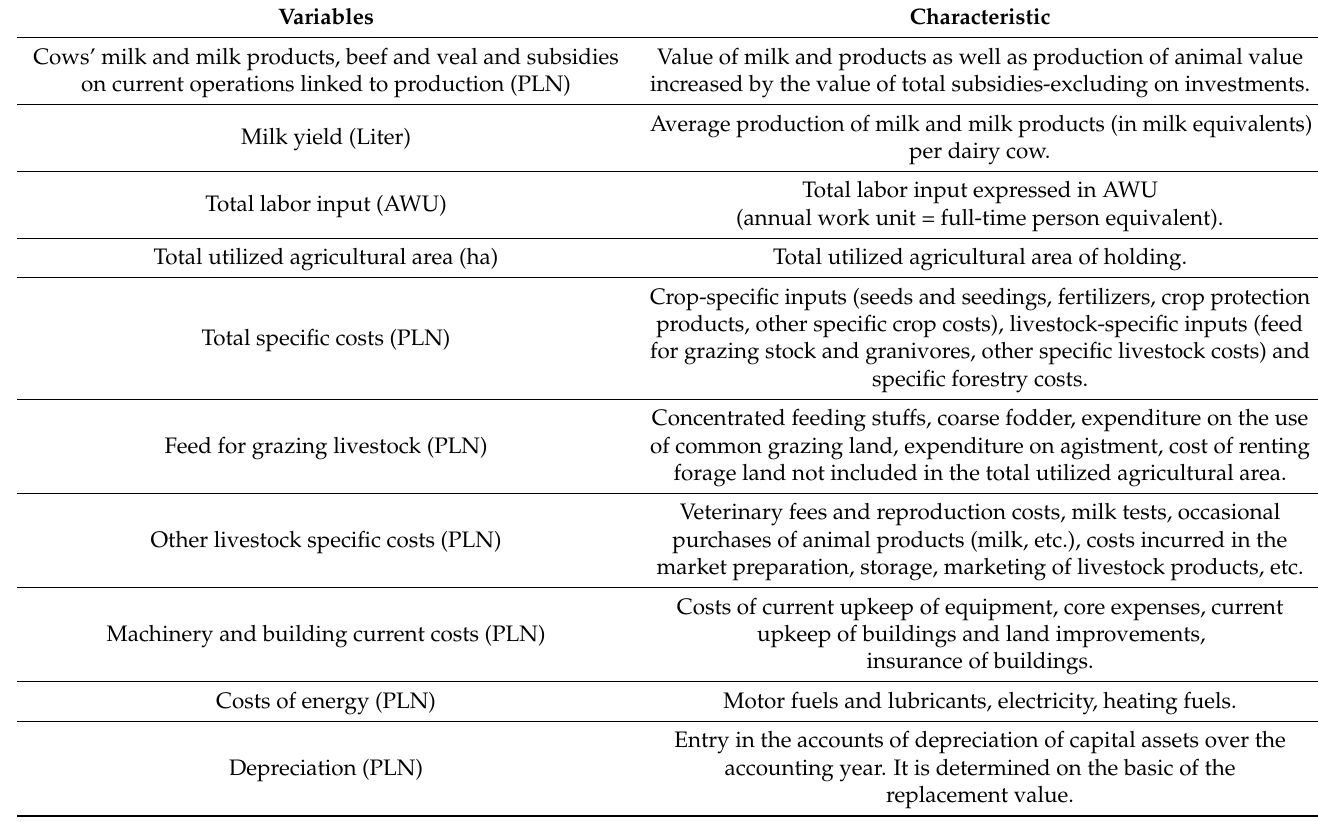
Table 1. Diagnostic variables adopted for the classification of dairy farms.